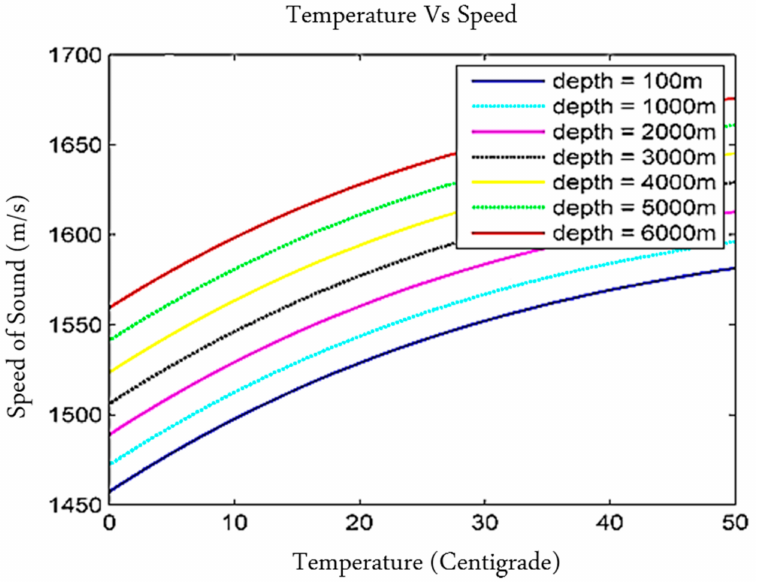
Figure 14. Temperature and depth-dependent speed